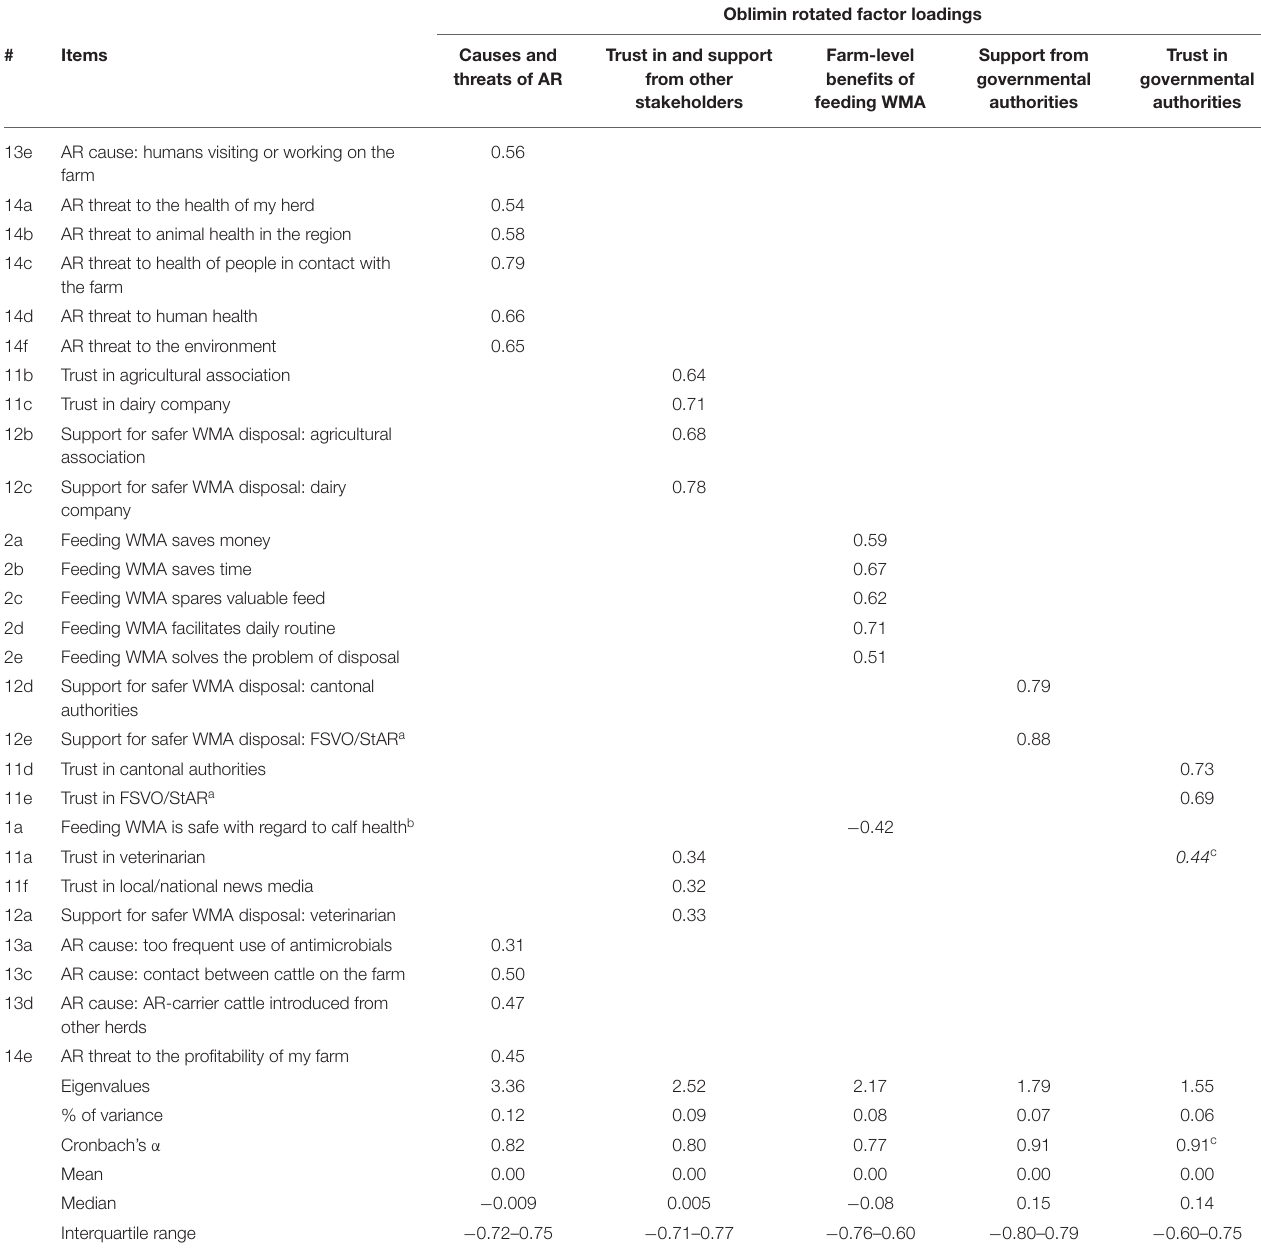
preferred to orthogonal rotation. The factors were interpreted as “biospherism,” “discipline,” “altruism,” and “tradition,” with proportions of explained variance of 0.24, 0.14, 0.10, and 0.08, respectively. Table 6 shows the factor loadings after oblimin rotation, and mean, median, and interquartile range of factor scores. Correlations between factors are shown in Table 5 .